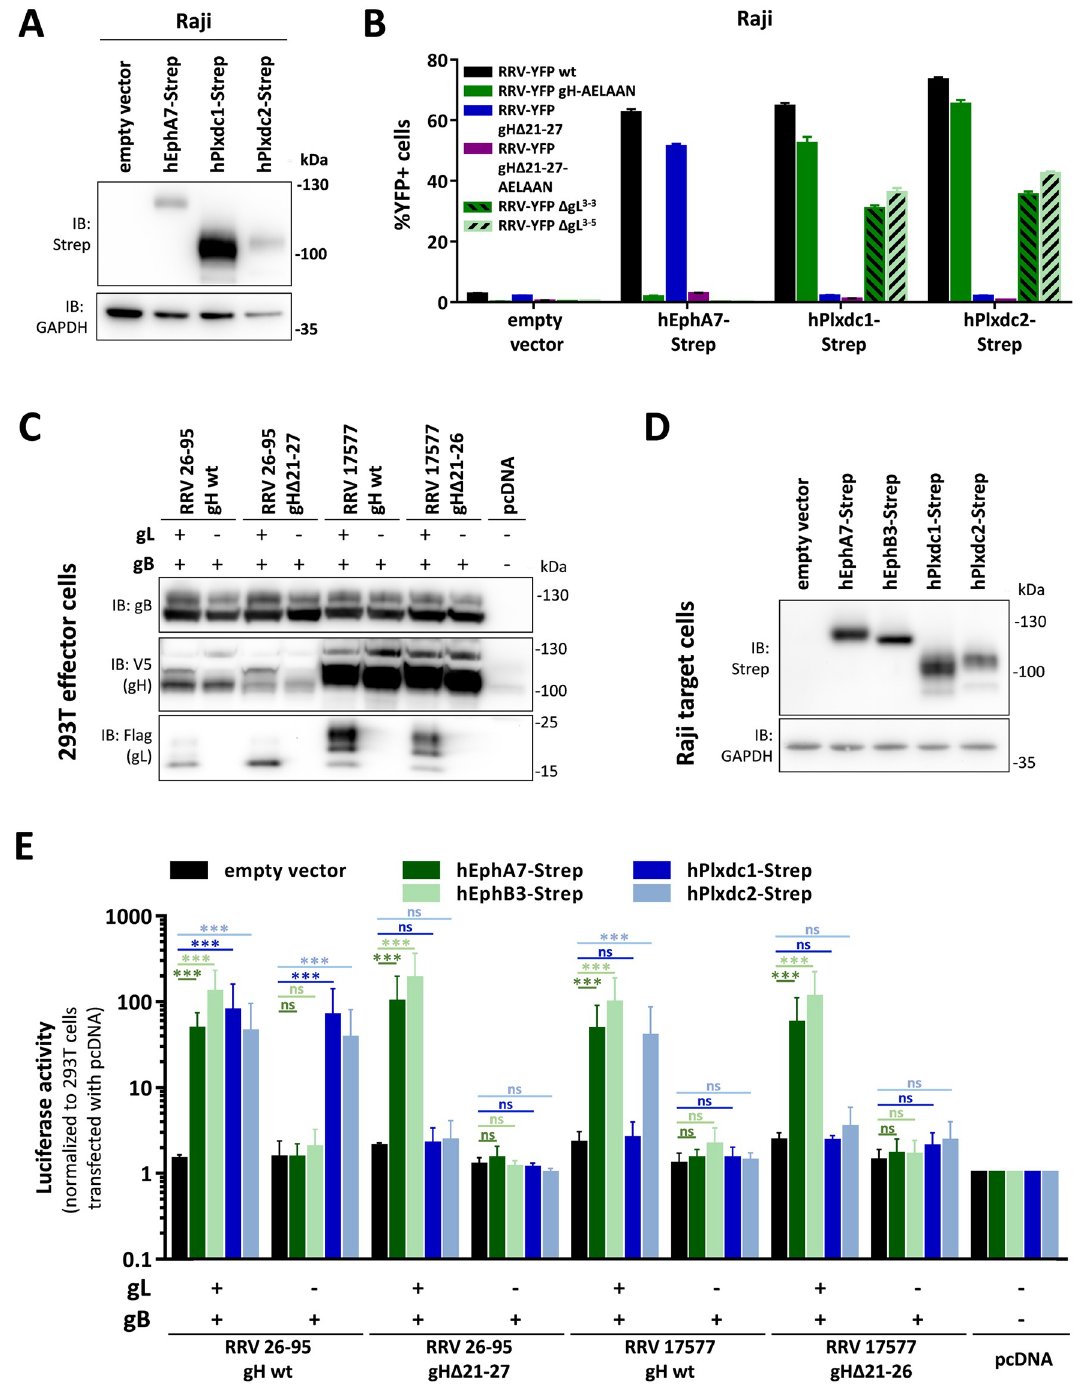
Fig 6. Plxdc1/2-dependent infection with RRV 26–95 does not require gL. A) Raji cells were transduced with TwinStrep-tagged human EphA7, Plxdc1 and Plxdc2 (hEphA7-Strep/ hPlxdc1-Strep/ hPlxdc2-Strep) expression constructs or an empty vector control and briefly selected by antibiotic resistance. Lysates of transduced Raji cell pools were analyzed for EphA7-Strep and Plxdc1/2-Strep expression by Western blot. B) Transduced Raji cells analyzed in (A) were infected with RRV-YFP wt, RRV-YFP gH-AELAAN, RRV-YFP gH Δ 21–27 or one of two RRV-YFP Δ gL clones normalized to genome copies as determined by qPCR. YFP expression as indicator of infection was measured by flow cytometry (triplicates, error bars represent SD). C-E) Cell-cell fusion assay: Transfected 293T effector cells were co-cultured with transduced Raji target cells as indicated. Cell-cell fusion was assessed after two days of co- culture. Protein expression of 293T effector cells transfected with empty vector or the indicated viral glycoprotein combinations (C)